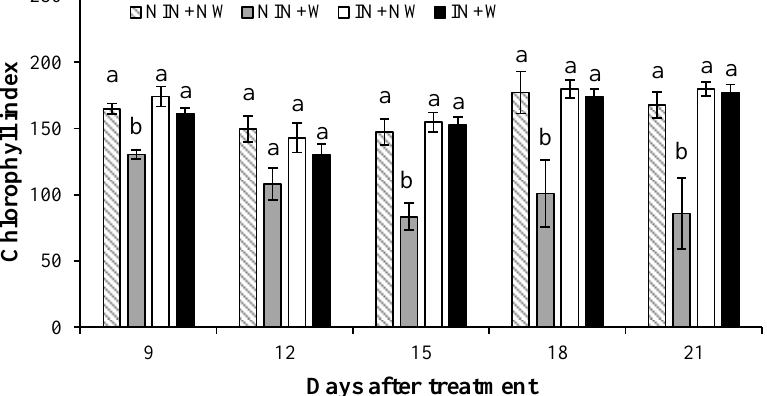
Figure 2. Chlorophyll index in R. sativus under waterlogged conditions and inoculated with A. brasilense . Averages followed by different letters at each sampling point show statistical differences according to Tukey’s test ( p < 0.05). Vertical bars in each average indicate standard error ( n = 11).